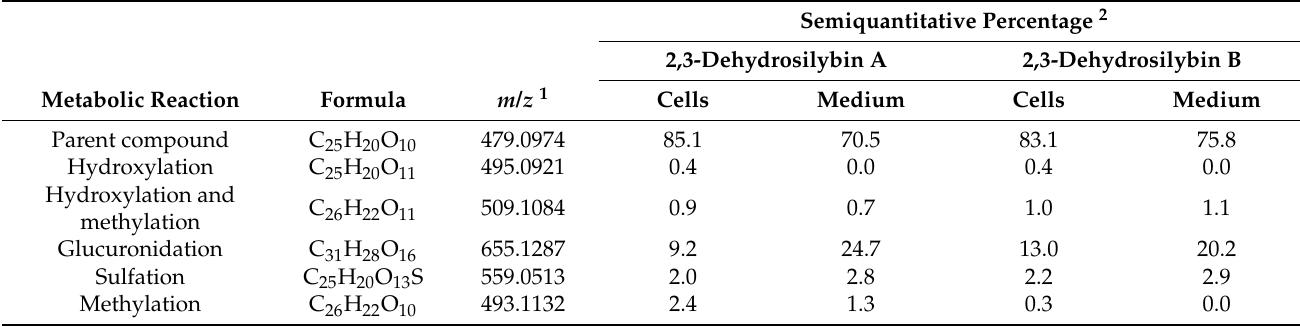
Table 1. Biotransformation of 2,3-dehydrosilybin A and 2,3-dehydrosilybin B in human